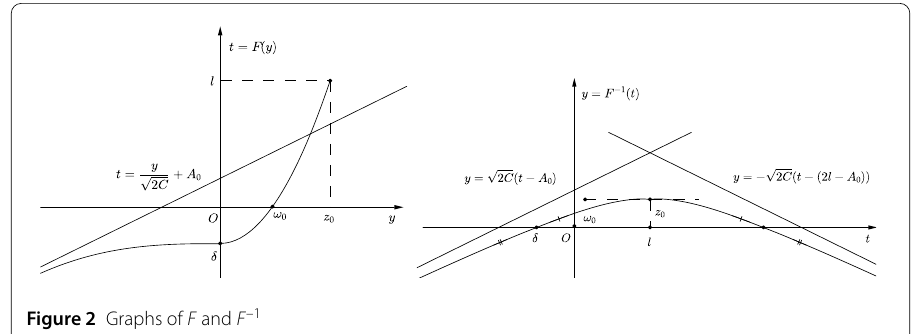
Figure 2 Graphs of F and F